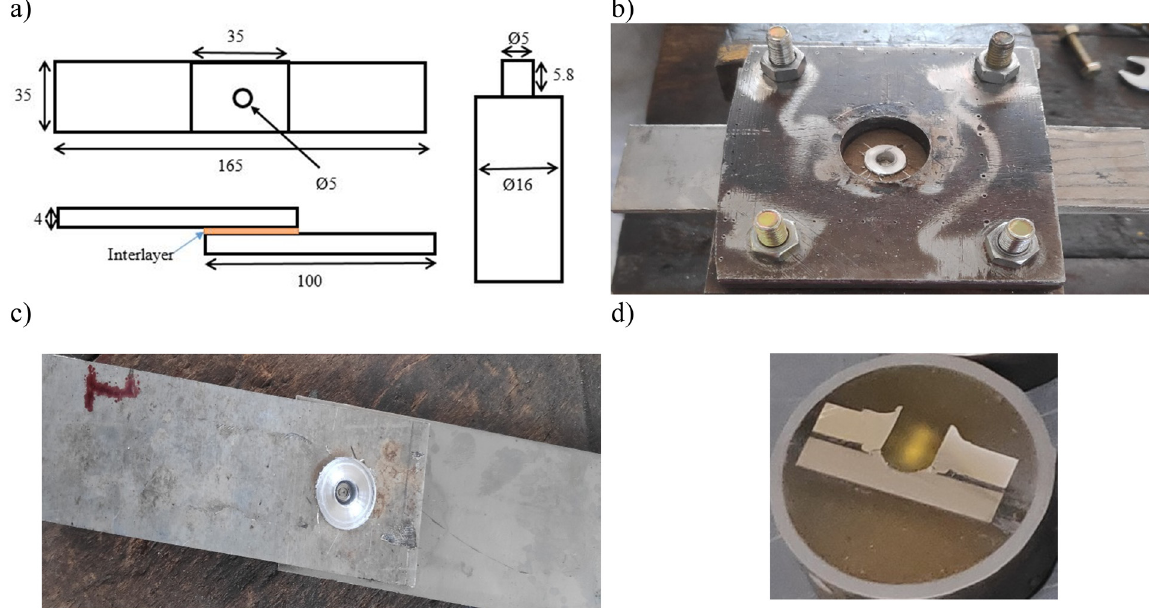
Figure 2: ( a ) Schematic of lap joint and friction stir spot tool ( mm ) , ( b ) specimen holder, ( c ) welded sample, and ( d ) sample for micro - structural analysis.